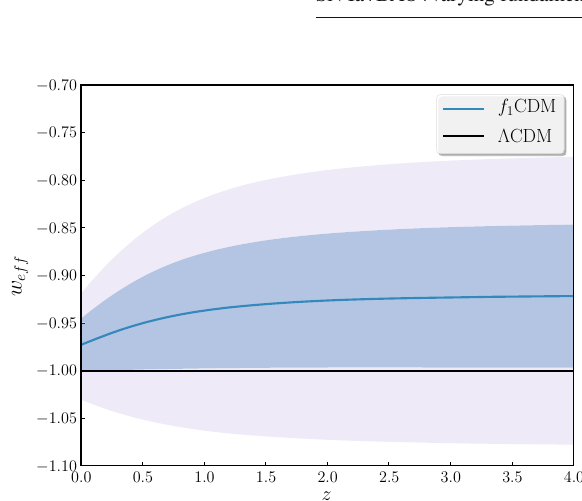
Table 2 Summary of the best-fit values of parameters for the f 1 CDM model with 1 σ uncertainties for different observations (OHD is the abbreviation of the observational H ( z ) data)